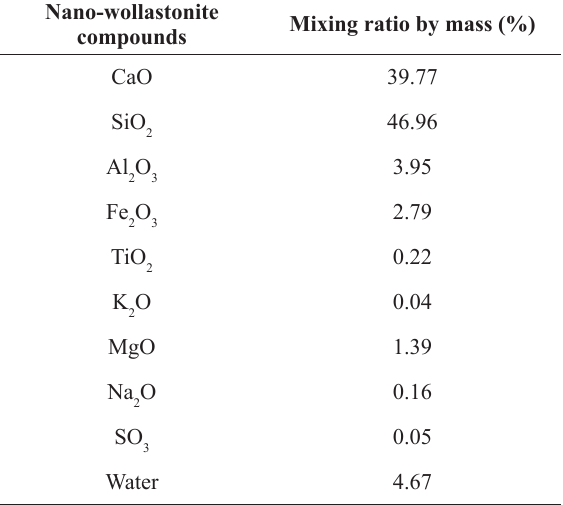
Compounds of the nano-wollastonite gel used for treatment purpose (Taghiyari et al.